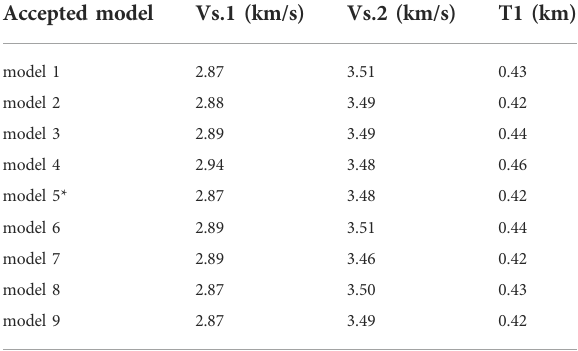
TABLE 1 The models fi tting the SP11 seismic